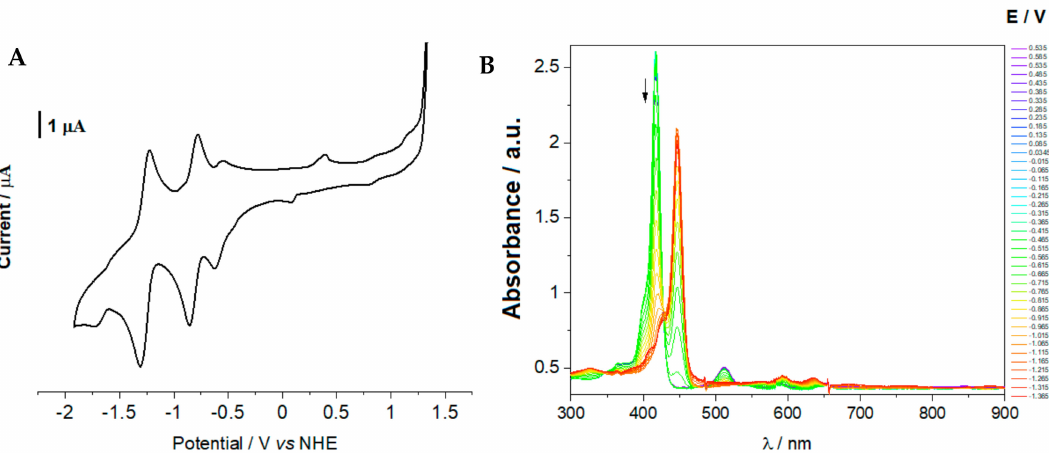
Figure 4. The cyclic voltammograms of ClTPP (concentration 0.5 mM) in DMSO in 0.2 M TBAP 20 mV / s with a vitreous carbon working electrode ( A ), and the absorption spectra of the ClTPP recorded for di ff erent applied electrode potentials ( B